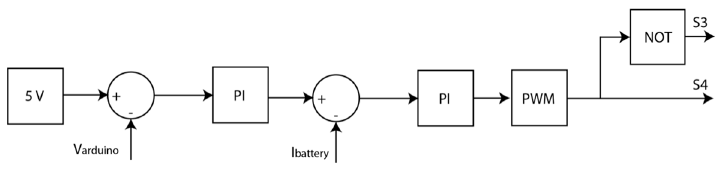
Figure 7. Control design for the piezoelectric system.